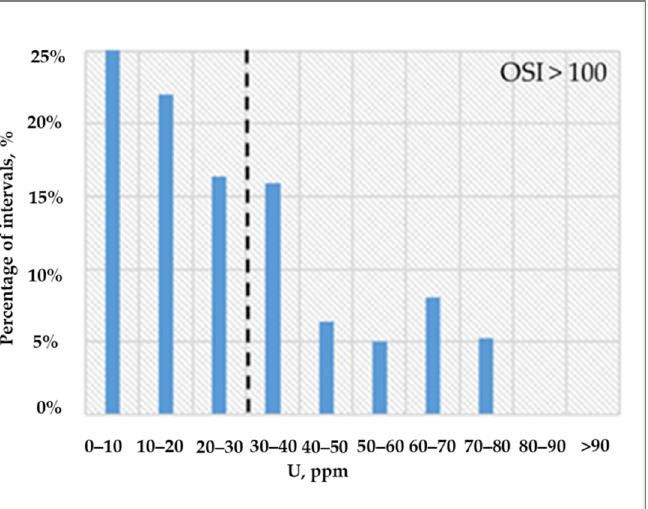
Figure 11. The number of intervals with OSI > 100 for different uranium concentrations.